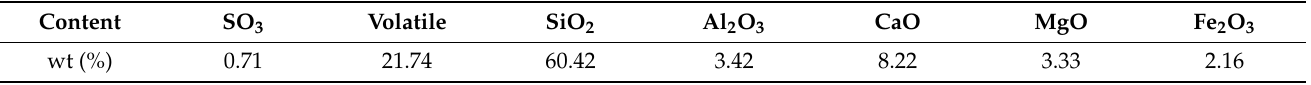
Table 1. Compositional analysis of wood